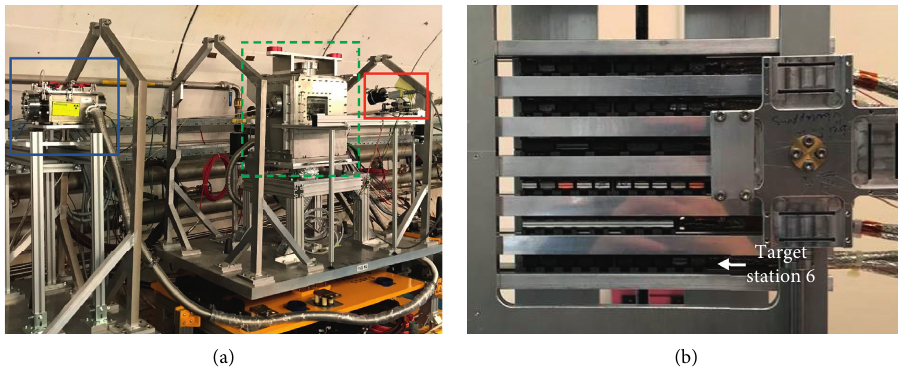
Figure 1: Experimental setup mounted in the HiRadMat irradiation area. The irradiation chamber housing the target holder is indicated by the dashed green frame. The horizontal translation stage with the mirror/rad-hard camera assembly is indicated by the red frame. The beam television (BTV) used to record the transversal beam size is indicated by the blue frame (a). Detailed view of the target holder that hosts the six individual target stations. The cross-shaped object fixed on the right side of the frame holds four sheets of radiation-hard glass to protect the main viewport from potential ejecta (b).